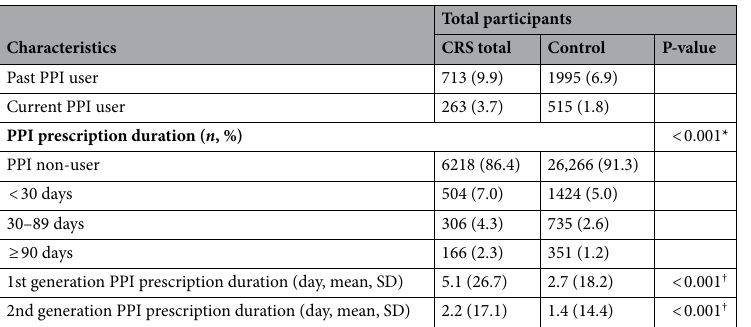
Table 1. General characteristics of participants. CCI Charlson comorbidity index, COPD chronic obstructive pulmonary disease, CRS chronic rhinosinusitis, DBP diastolic blood pressure, GERD gastro-esophageal reflux disease, NSAID non-steroidal anti-inflammatory drug, PPI proton pump inhibitor, SBP systolic blood pressure, SD standard deviation. *Chi-square test. Significance at P < 0.05. † Wilcoxon rank-sum test. Significance at P < 0.05. ‡ Obesity (BMI, body mass index, kg/m 2 ) was categorized as < 18.5 (underweight), ≥ 18.5 to < 23 (normal), ≥ 23 to < 25 (overweight), ≥ 25 to < 30 (obese I), and ≥ 30 (obese II).